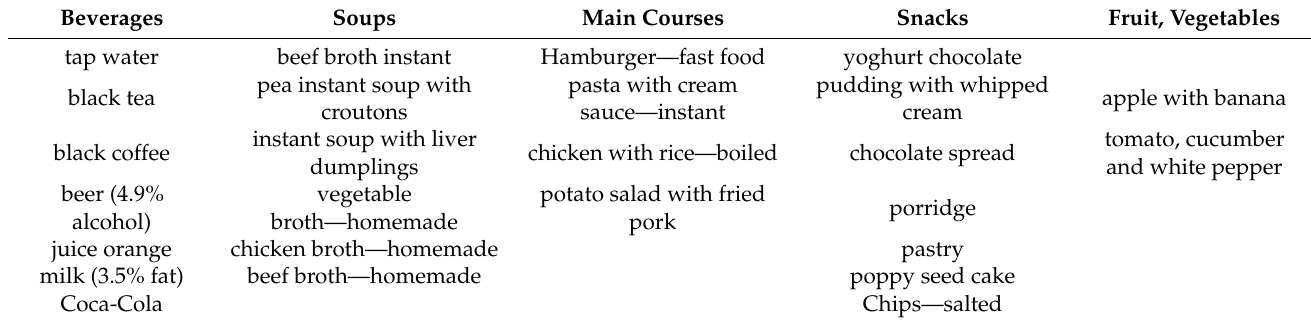
Table 1. Overview of tested real foods and